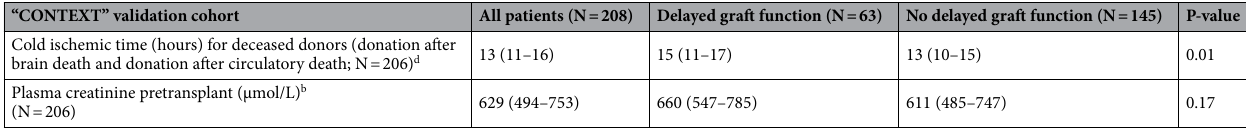
Table 1. Demographic and clinical characteristics of renal transplant recipients in the discovery cohort and in the validation cohorts who were stratified according to posttransplant delayed graft function. Delayed graft function was defined by at least one dialysis within the first week after transplantation. Continuous data are presented as median (interquartile range). Categorical data are presented as numbers (percent). Groups containing continuous data were compared using Mann–Whitney test, whereas groups containing categorical data were compared using Fisher’s exact test or Chi-square test, as appropriate. a HLA denotes human leukocyte antigen. b To convert the values for creatinine to milligram per deciliter, divide by 88.4. c Numbers retrieved in “TxL” validation cohort, all other data are obtained from the entire cohort. d Numbers retrieved in “CONTEXT” validation cohort, all other data are obtained from the entire